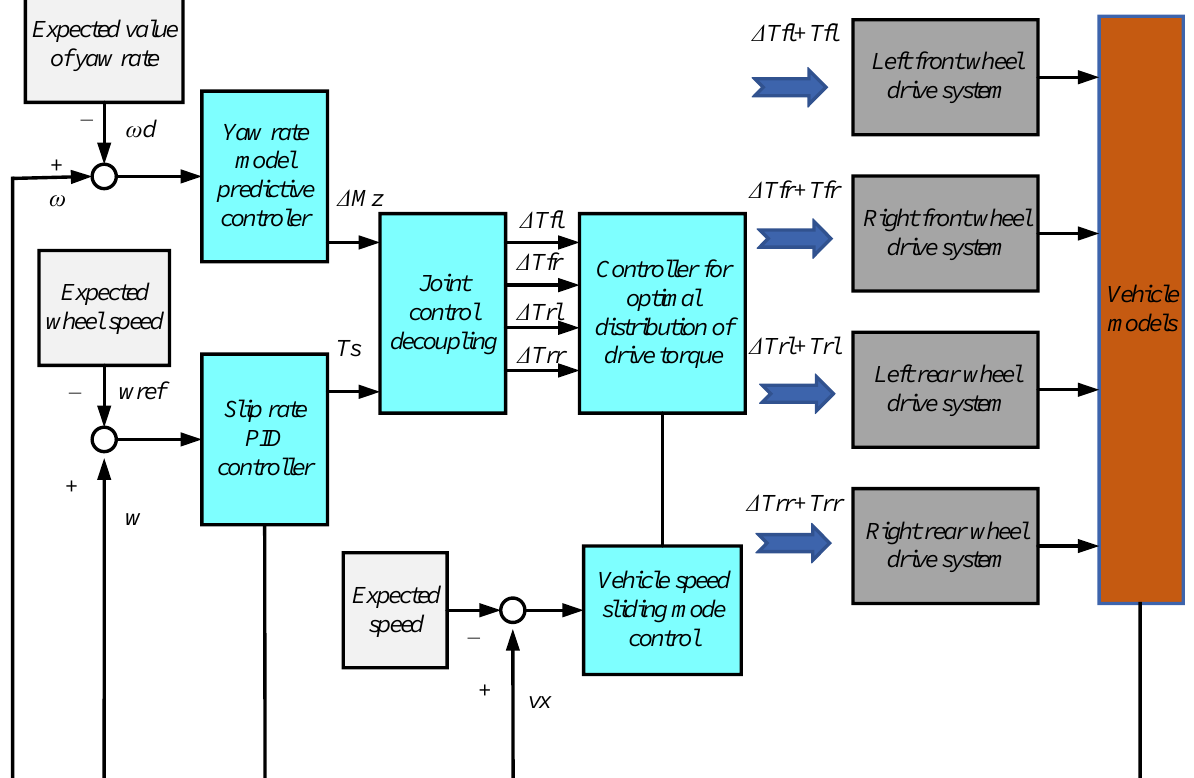
Figure 7. Decoupled optimal control system